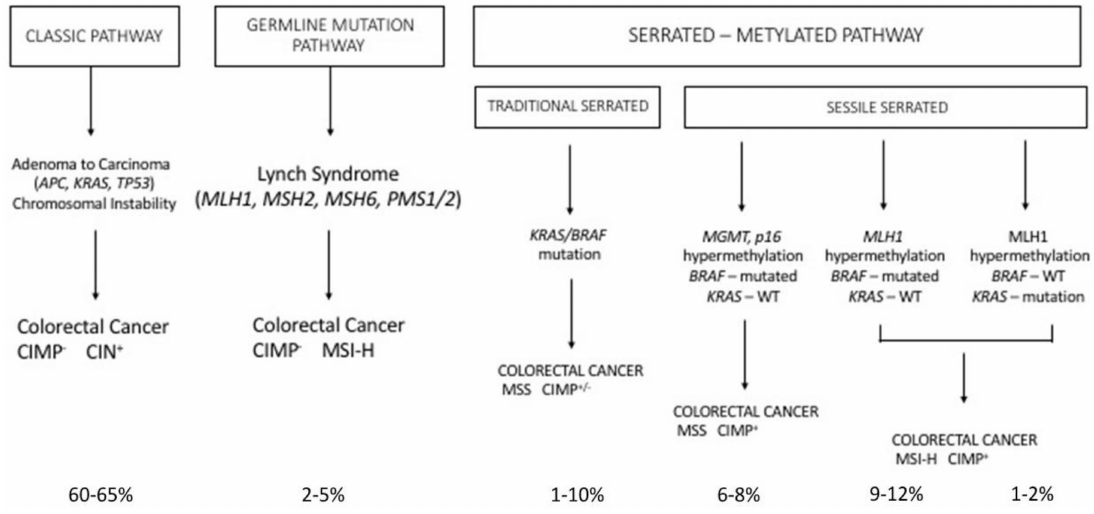
Figure 3. Outline of the three main pathways of colon carcinogenesis. A classic, conventional pathway is initiated by APC mutations and progresses through the sequential accumulation of genetic mutations and chromosomal instability (CIN), causing microsatellite stable (MSS) tumors. The germline mutation pathway is related to germline mutation of mis-match repair (MMR) genes, seen in Lynch syndrome (hereditary non-polyposis coli) and leads to microsatellite instability (MSI-H). The sessile-serrated-methylation pathway is heterogeneous: a traditional serrated pathway, related to KRAS/BRAF mutations, leading to MSS tumors, with a variable CpG island methylator phenotype (CIMP); a traditional serrated pathway, comprising three subgroups: one leading to MSS and CIMP + tumors, one associated with BRAF mutated and KRAS-WT and hypermethylation of MGMT and p16 gene promoters; the two others leading to MSI-H and CIMP + tumors, one associated with BRAF -mutations and KRAS-WT and hypermethylation of the MLH1 gene promoter and the other one associated with BRAF-WT and KRAS -mutated and hypermethylation of the MLH1 gene